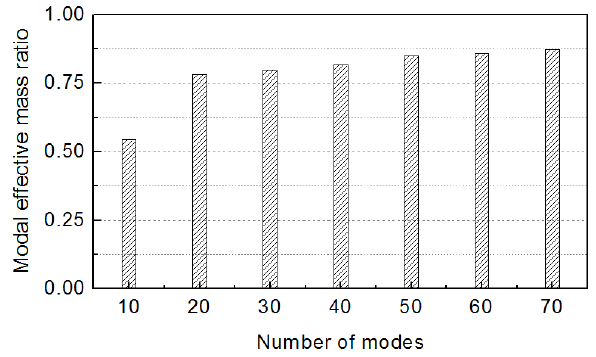
Figure A2. Modal mass ratio of different first modes.